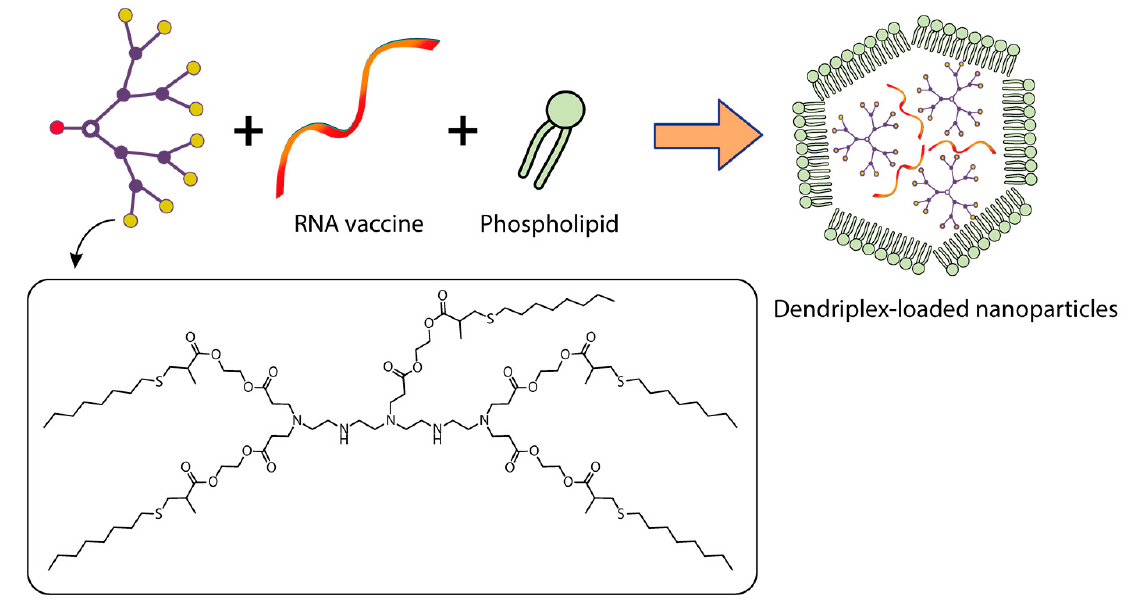
Figure 9. Constructing vaccine nanoformulations based on amphiphilic dendron 5A2-SC8.